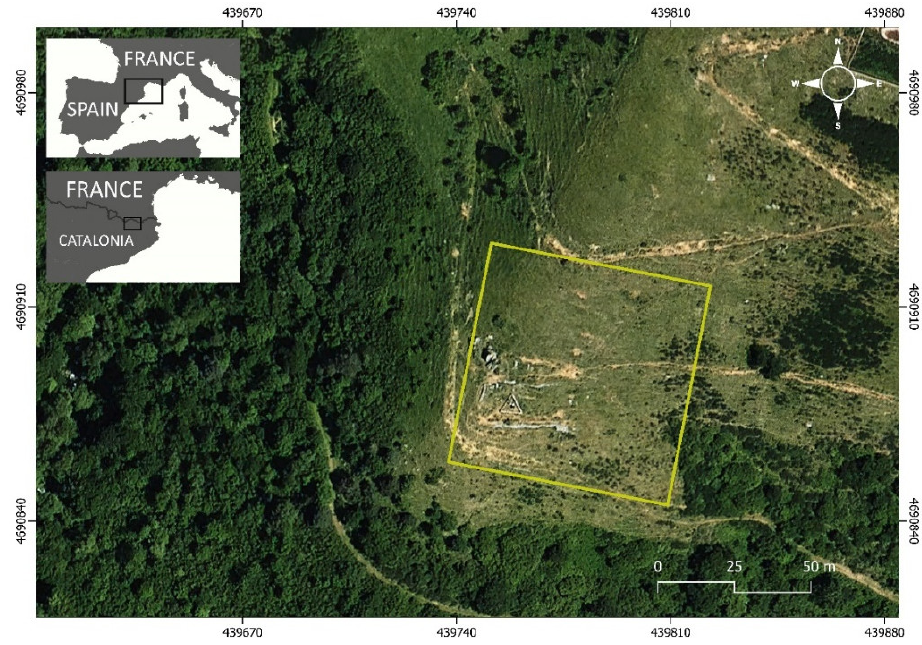
Figure 1. Map of the study plot, represented by the yellow square on the orthophoto map of the